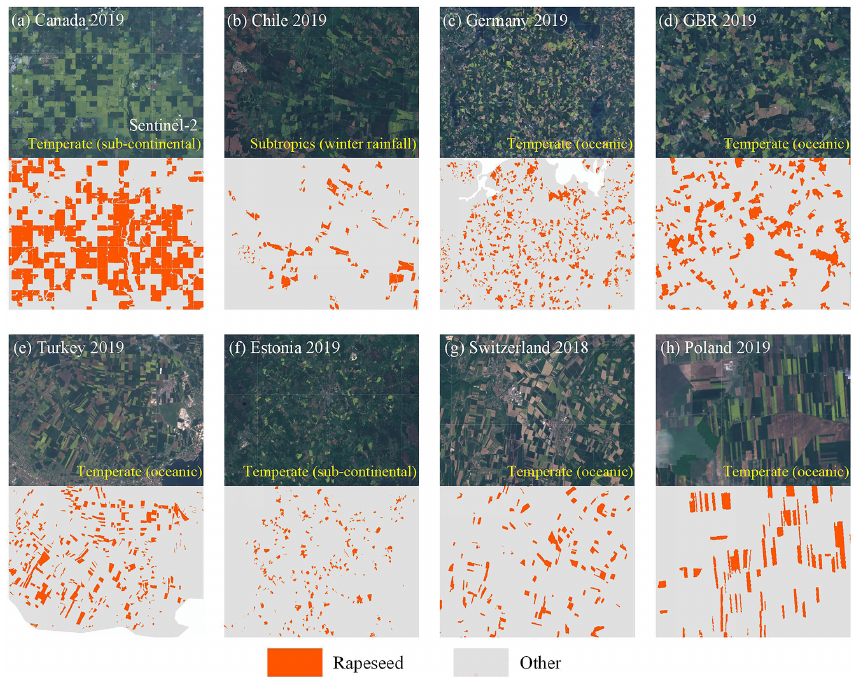
Figure 9. Spatially explicit details of rapeseed maps in eight countries with diverse crop structures in different years. The names of climate zones are given in yellow. RGB composite images comprise red (b4), green (b3), and blue (b2) bands from Sentinel-2 good-quality obser- vations during the rapeseed flowering period (image source: Copernicus Sentinel-2 data). Climate zone data are from the Food Insecurity, Poverty and Environment Global GIS